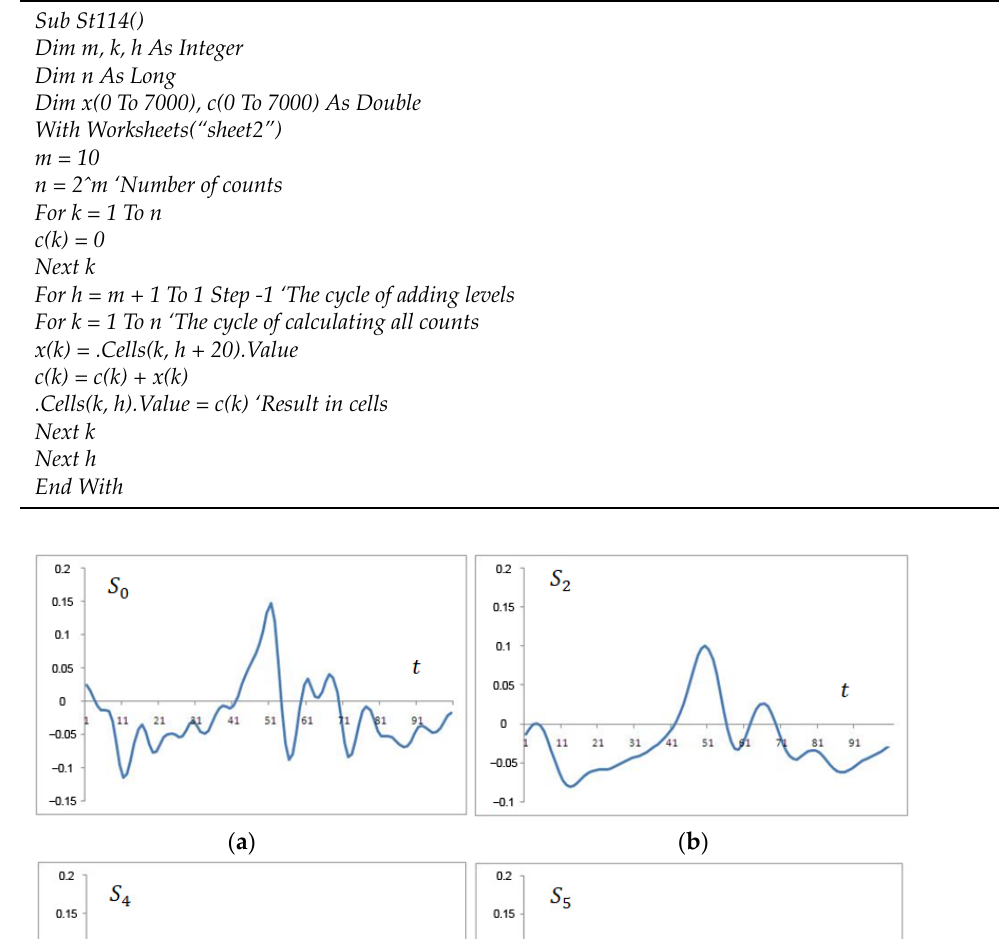
Table 1. Listing of the program for MSA in VBA.